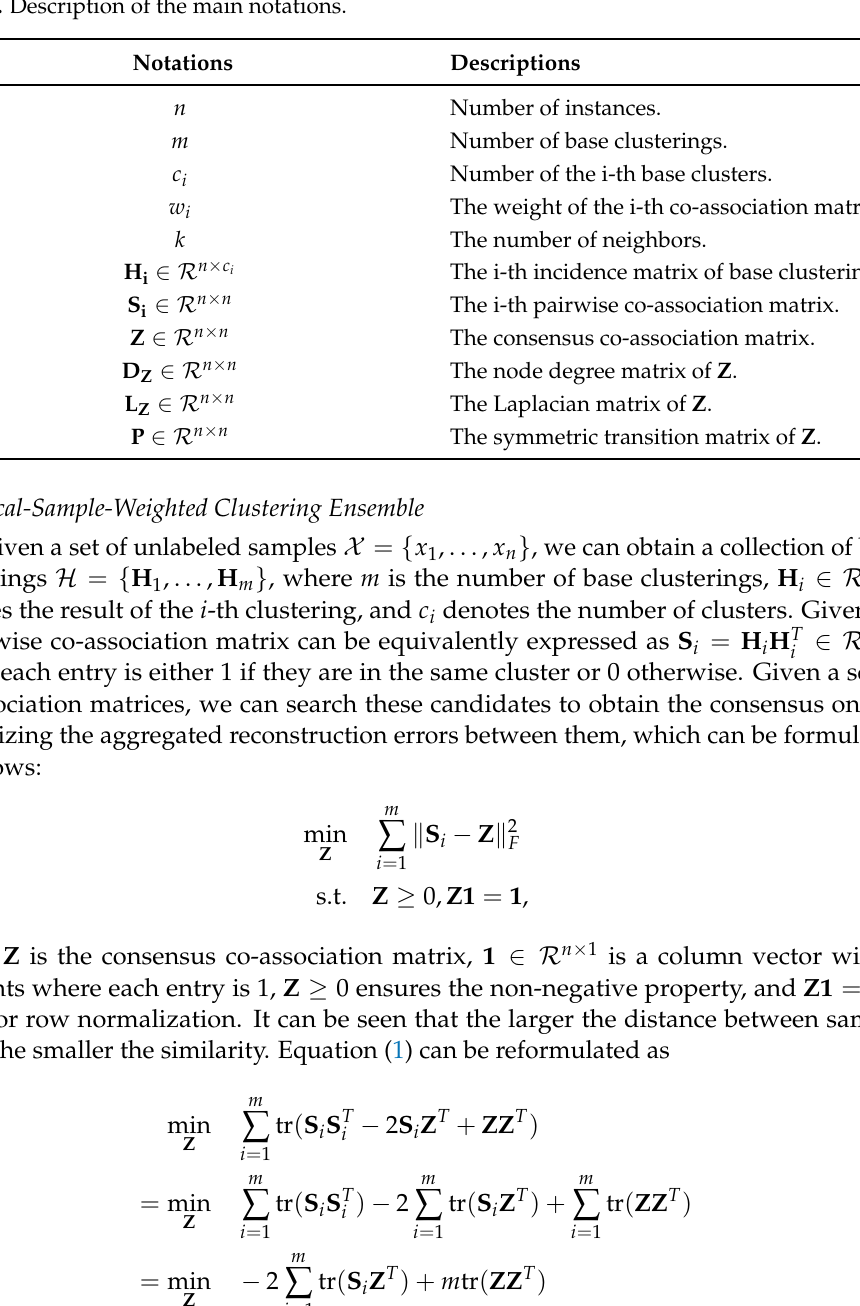
Table 1. Description of the main